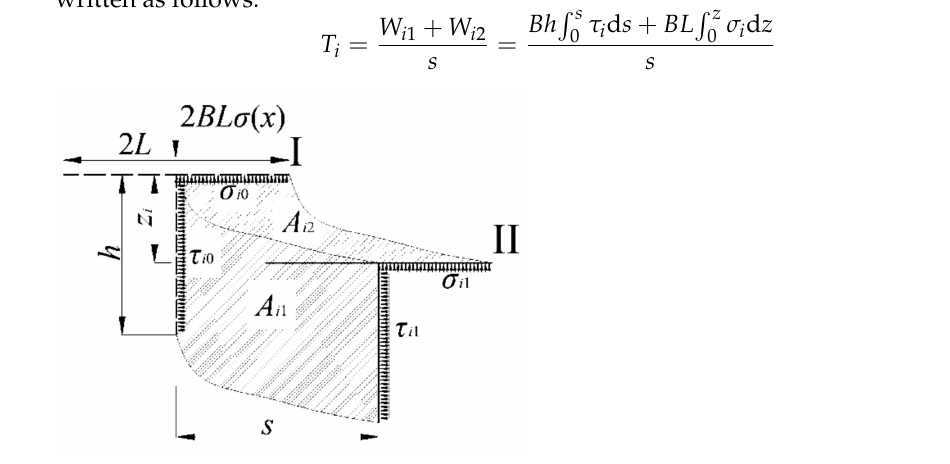
Figure 8. Kinetic process of single-track shoe.